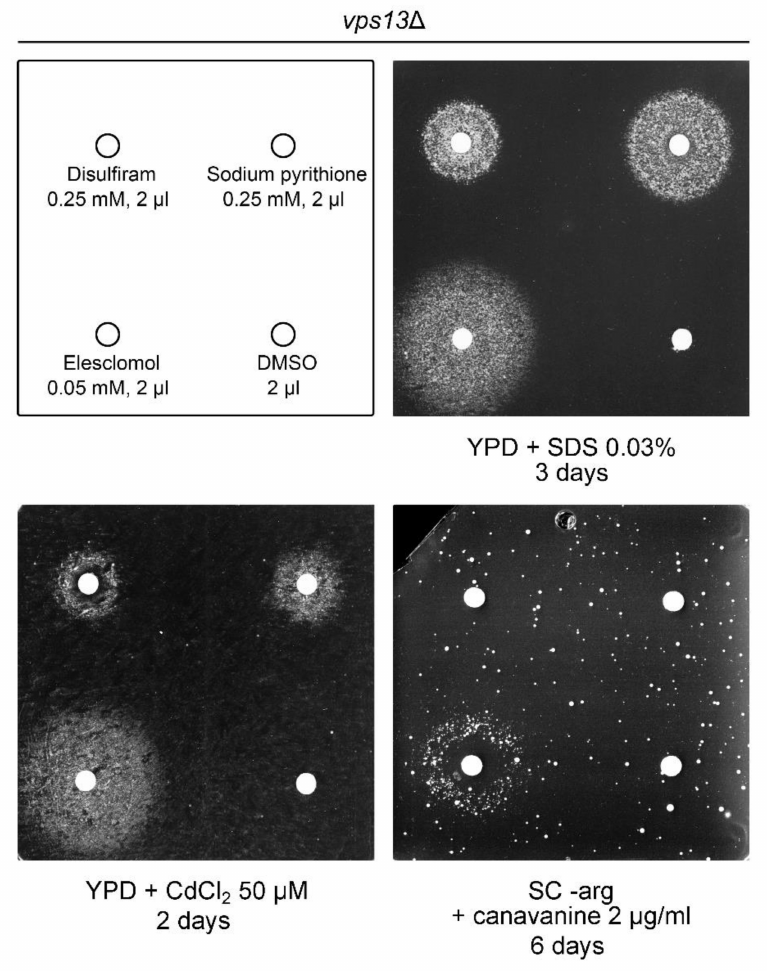
Figure 5. Copper ionophores suppress several phenotypes of vps13 ∆ . The vps13 ∆ mutant cells were spread onto the plates with respective media and tested substances were spotted on the filter papers. The order of the substances and concentrations used are indicated. Dimethyl sulfoxide (DMSO) was used as a negative